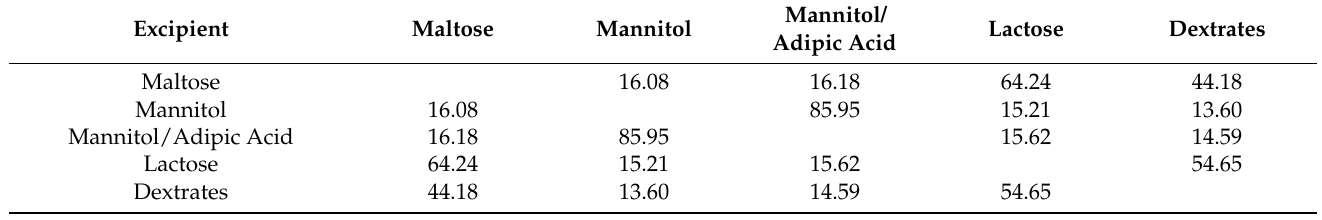
Table 2. f2 comparison. Kinetic hydrogen generation measurements of tablet batches manufactured with different excipients were compared with the f2 comparison; according to SUPAC guidelines release profiles of tablets with a f2 value between 50 and 100 are considered similar.